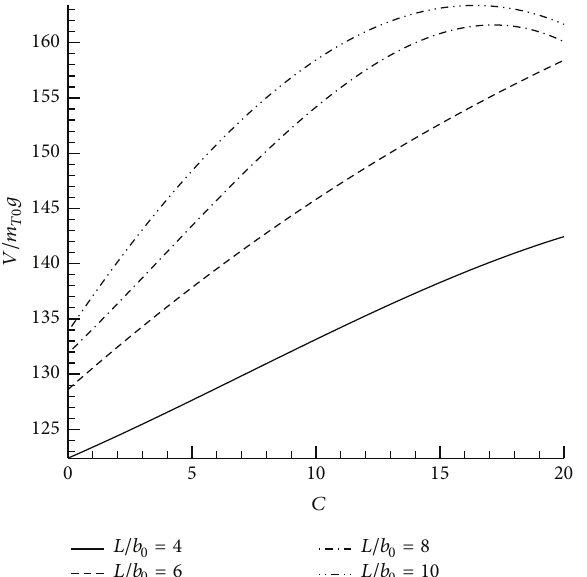
Figure 9: Tapering and length effects on bimorph with parallel connection, modified thickness.